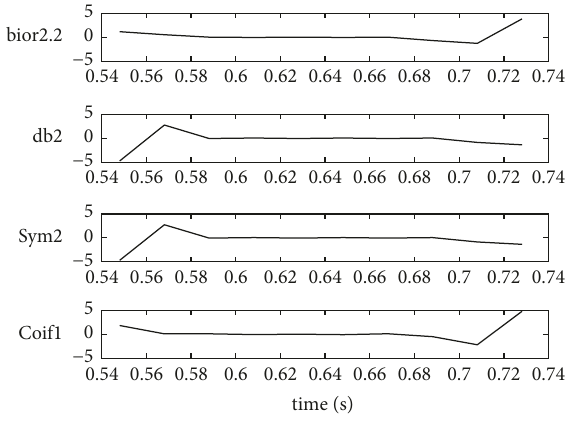
Figure 4: The detail coefficients of the first layer with different wavelets (0.55s ≤ t ≤ 0.75s).